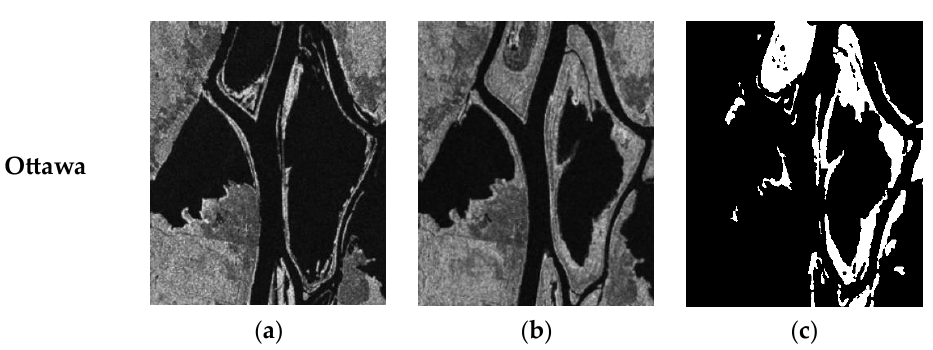
Figure 5. Ottava dataset. ( a ) Image acquired in May 1997; ( b ) image acquired in August 1997; ( c ) ground truth.